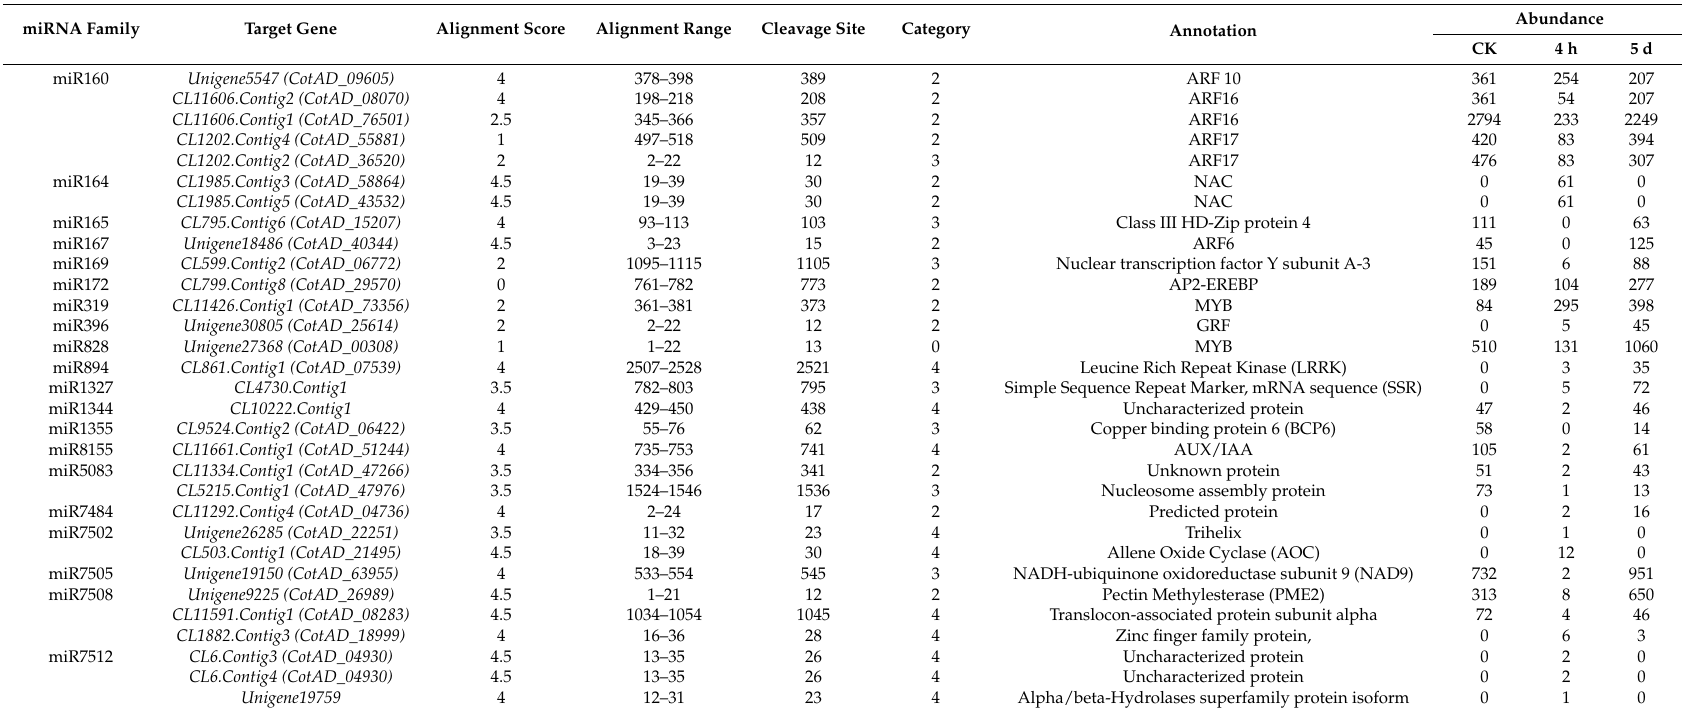
Table 3. Target genes of miRNAs identified in